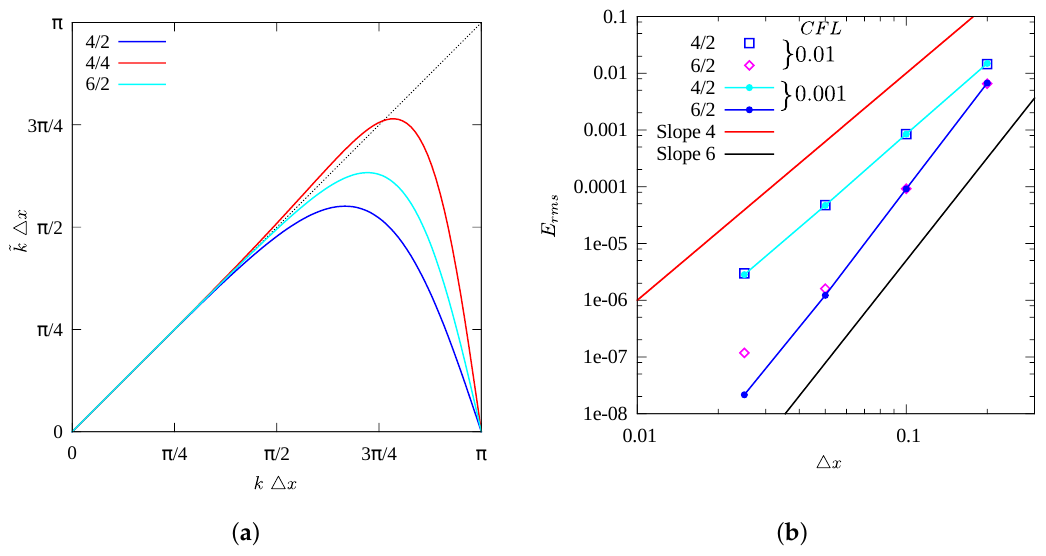
Figure 1. ( a ) Modified wavenumber characteristics of Hixon–Turkel split derivative formulas. ( b ) Effective orders of truncation error. ( a ) Modified wavenumber, ( b ) Order